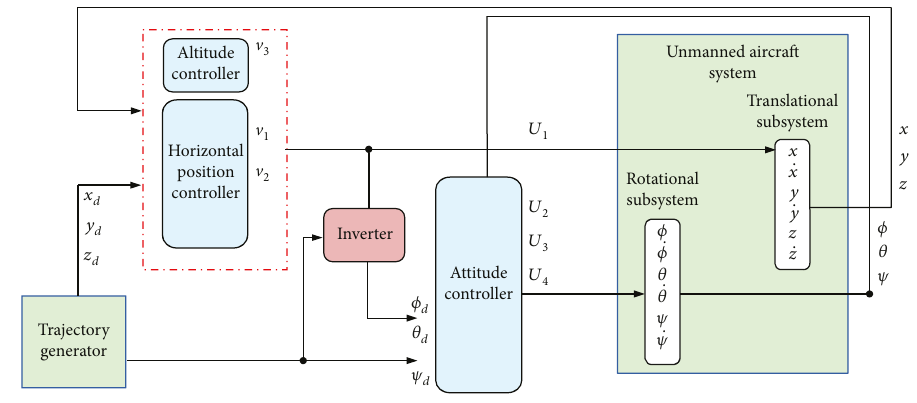
Figure 2: The control general structure for the quadrotor